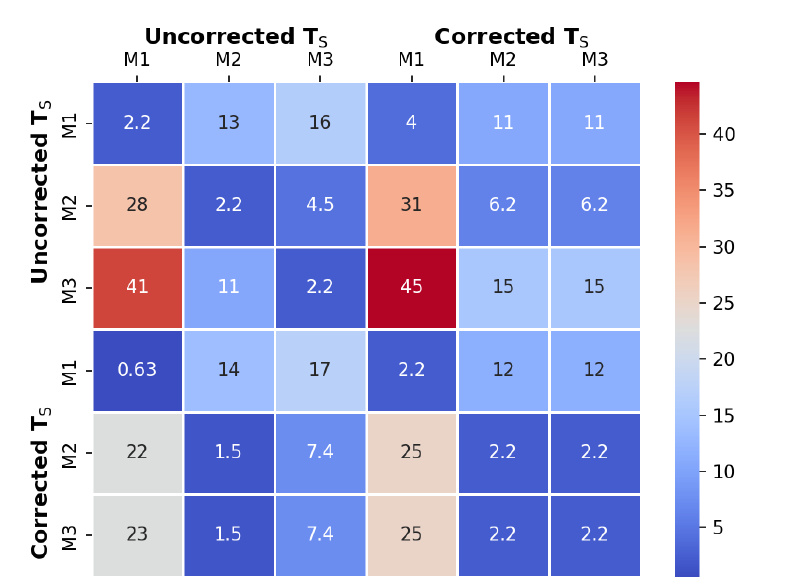
Figure 8. The relative error between methods and approaches when estimating the turbidity concen- tration using the fitted models from the data in Figure 4a,c and Table